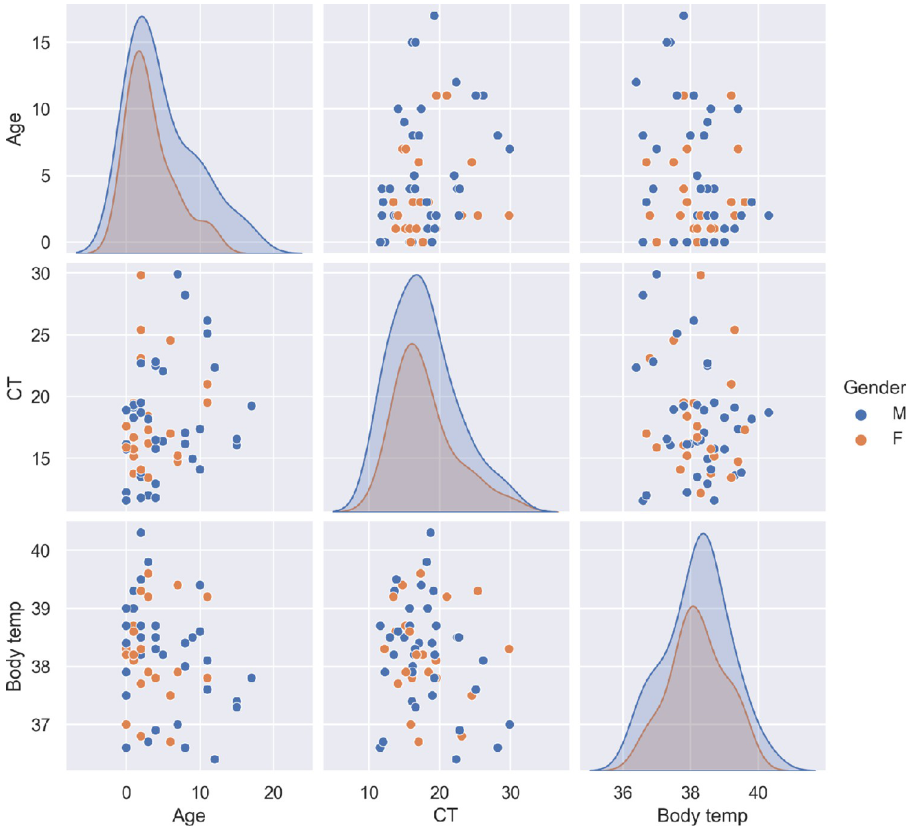
Fig 3. Distribution of CT values, body temperature and age of pediatric patients infected by Omicron variants BA.2.10.1 and BA.2.2. No sexual dimorphism was observed in this study.